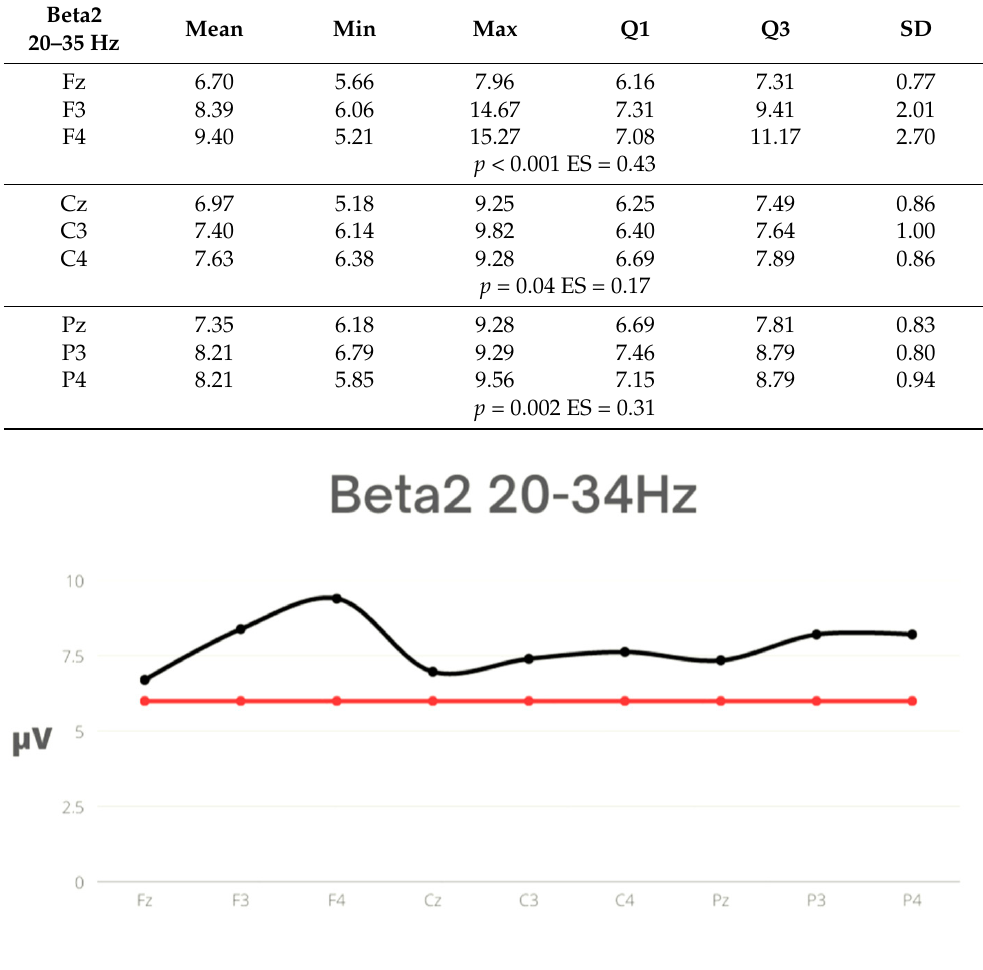
Figure 6. Mean values for Beta2 against the reference standard.